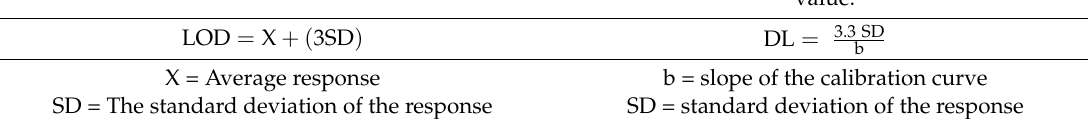
Table 3. Accepted methods for calculating the limit of detection (LOD) or detection limit (DL). APVMA a ICH b The DL of an individual analytical procedure is the The LOD of an analytical method is the lowest lowest amount of analyte in a sample which can be amount of an analyte in a sample that can be detected, detected but not necessarily quantified as an exact but not necessarily quantified as an exact value.